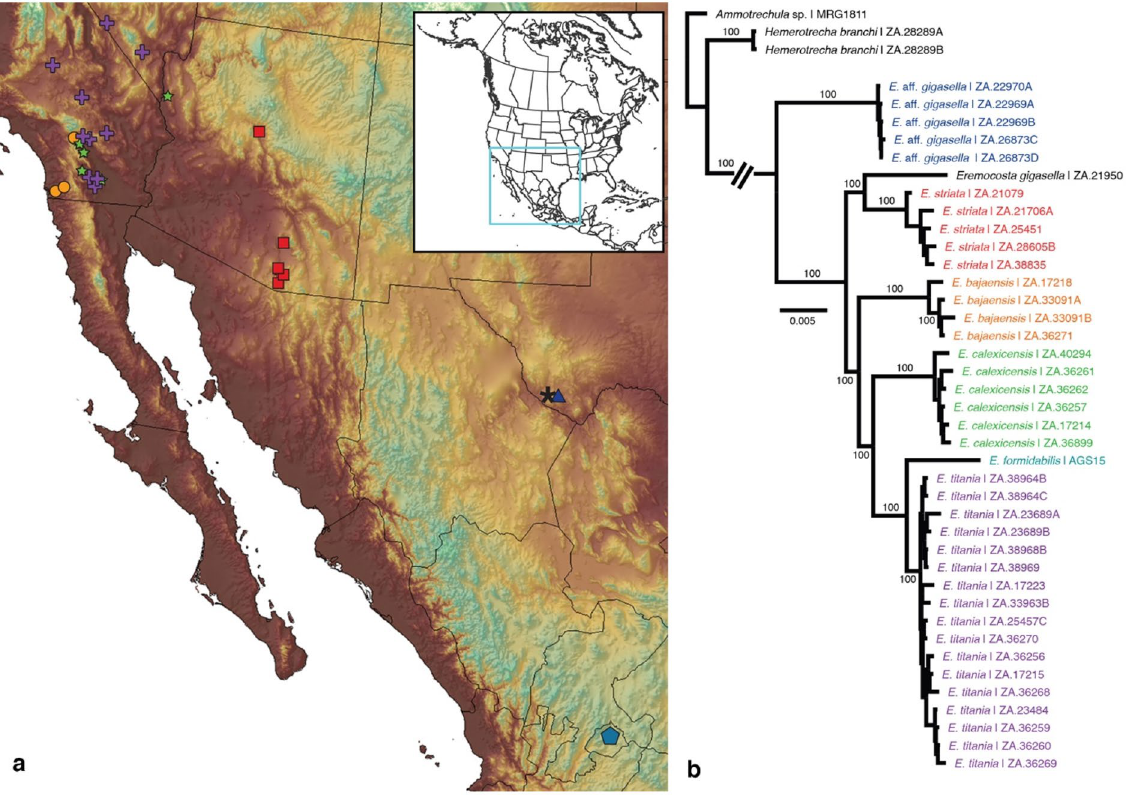
Figure 1. ( a ) Map showing locations of Eremocosta samples used in this study. Cyan pentagon: E. formidabilis . Blue triangle: E. aff. gigasella . Black asterisk: E. gigasella . Red square: E. striata . Orange circle: E. bajaensis . Green star: E. calexicensis . Purple cross: E. titania . ( b ) Maximum likelihood tree topology recovered from the analysis of 42 solifugid samples and 521,343 sites using the GTR + F + R2 model as selected by ModelFinder (m21; lnL = − 908,151.1928). Numbers on nodes indicate ultrabootstrap support. Nodes without numbers were supported by less than 100%. Distribution map was generated in ArcGIS v. 10.1 (ESRI, Redlands, CA, USA) using the locality coordinates, a base map from ArcGIS and a digital elevation model from DIVA-GIS, available at http:// www. diva- gis. org/